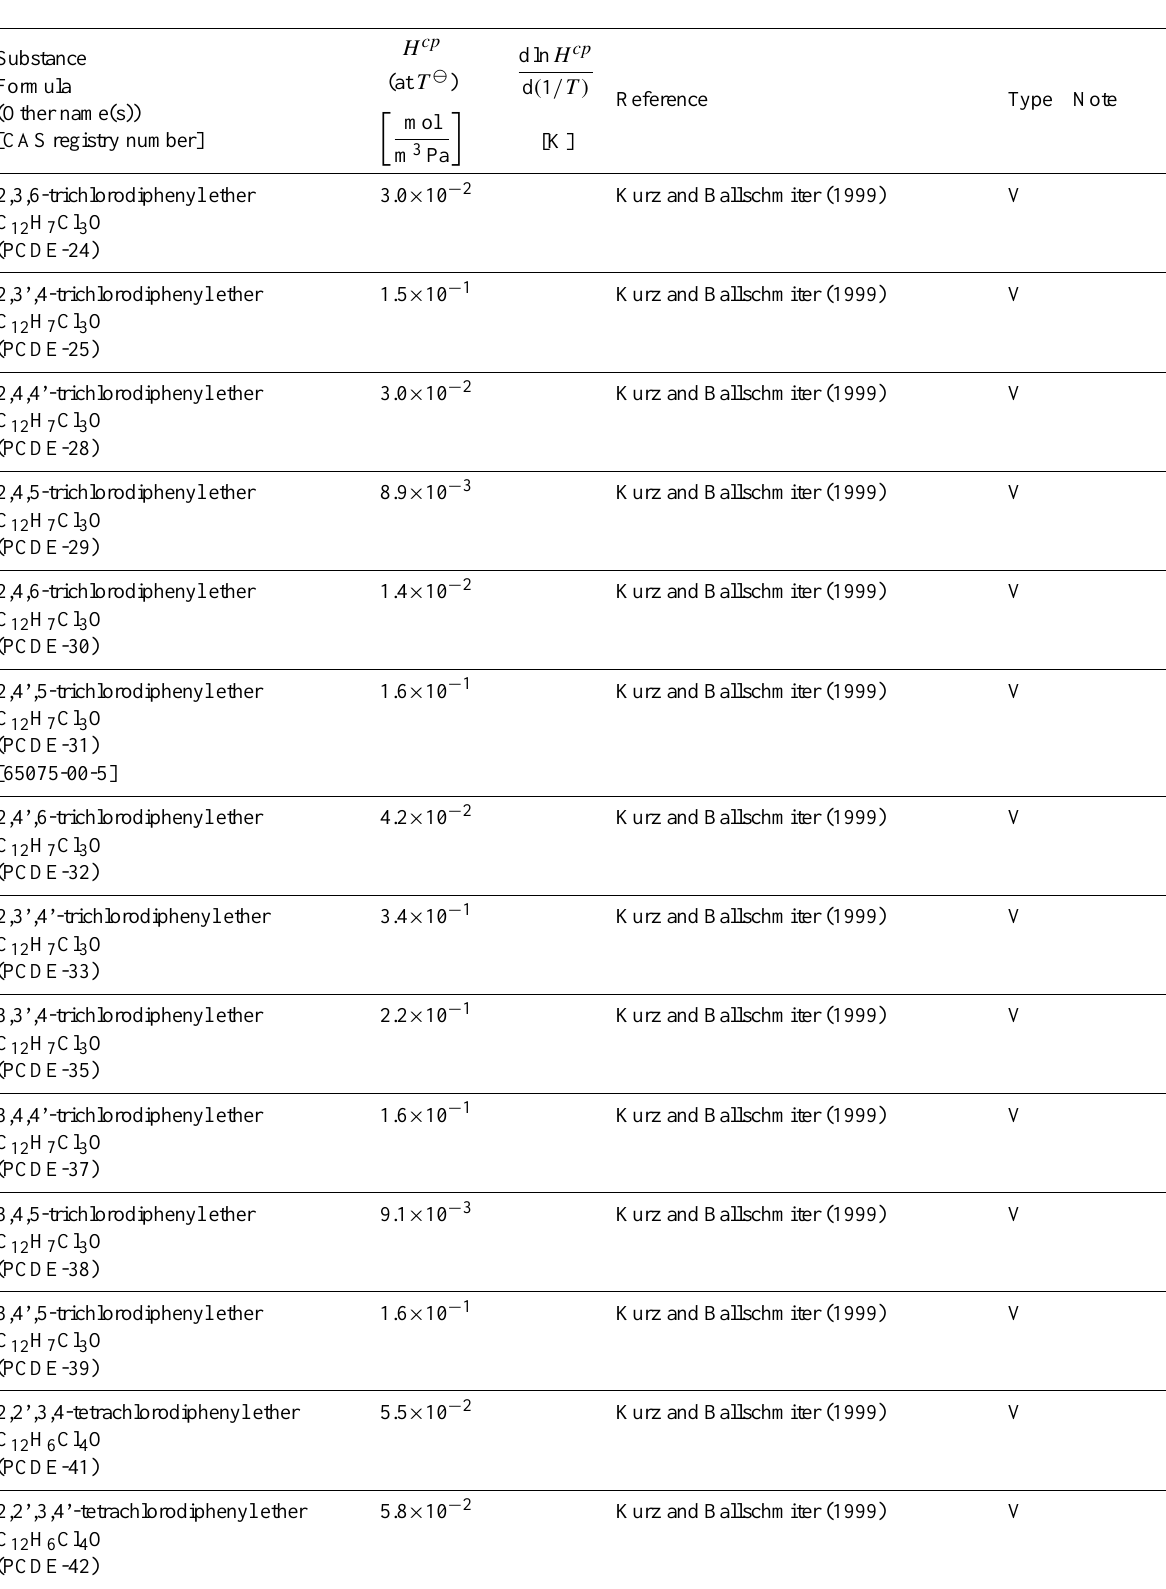
Table 6: Henry’s law constants for water as solvent